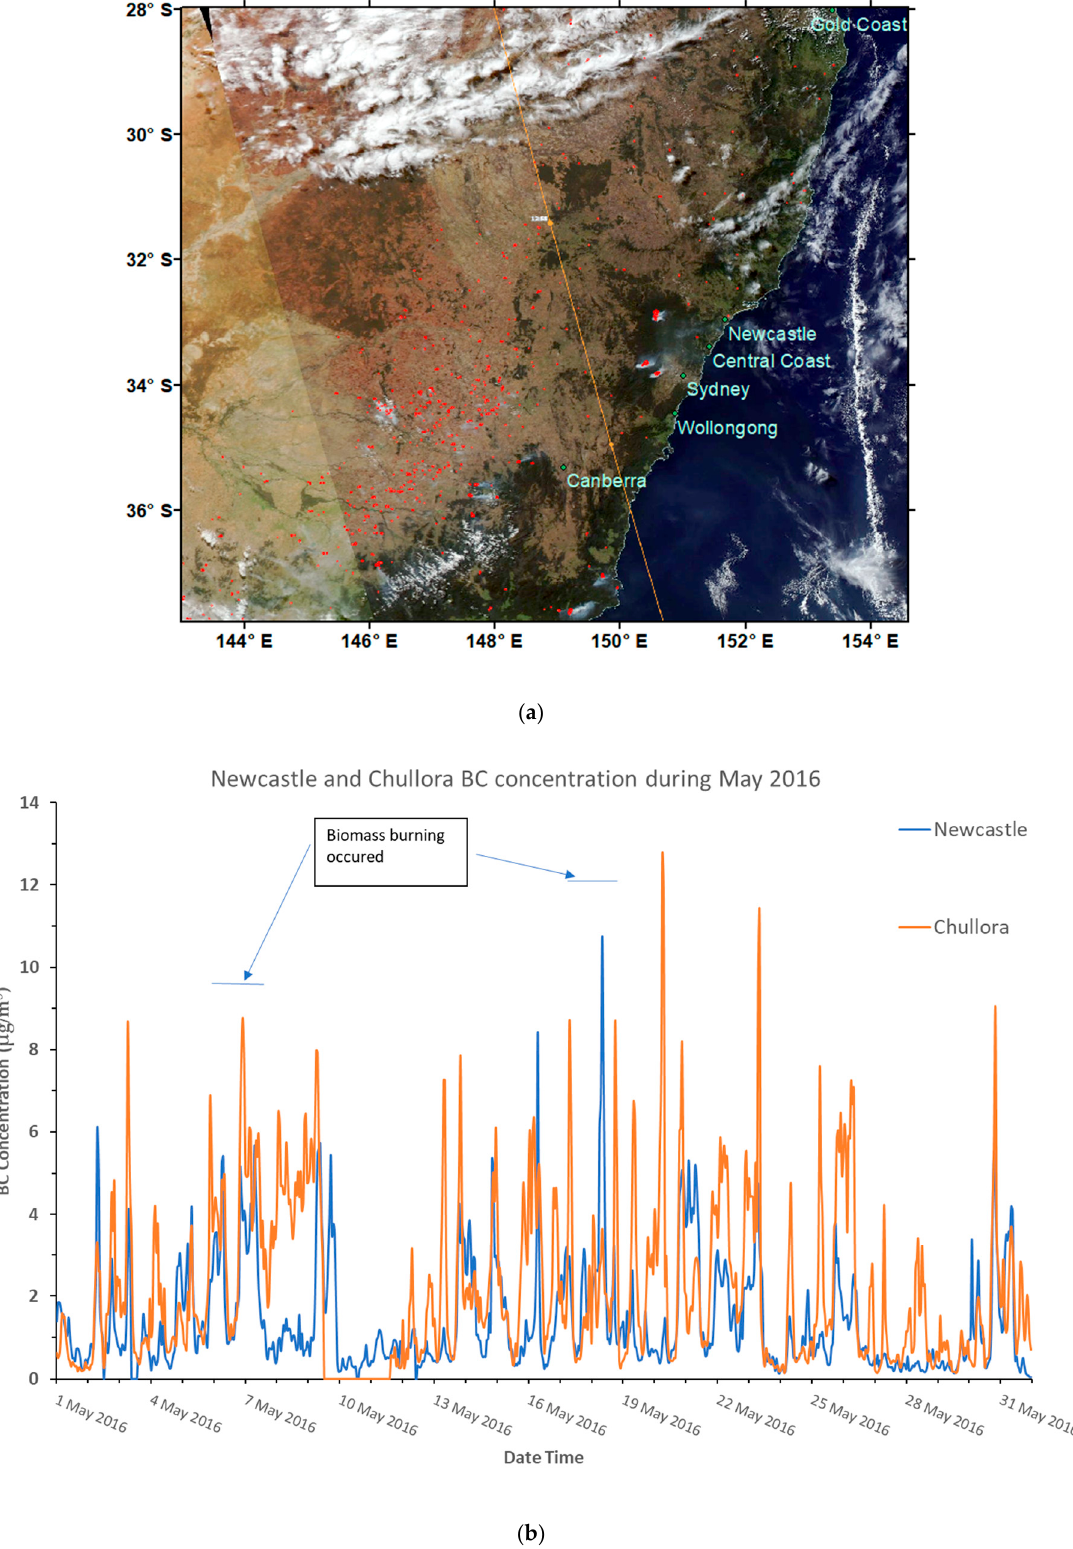
Figure 10. ( a ) Biomass burning hot spots and smoke plumes in the Blue Mountains west of Sydney and Newcastle as detected by MODIS satellites on 6 May 2016; and ( b ) hourly BC concentration as measured by aethalometer at Chullora and Newcastle from 1 to 30 May 2016. The biomass burning for Hazardous Reduction Burnings occurred during 6–7 and 17–18 May 2016.